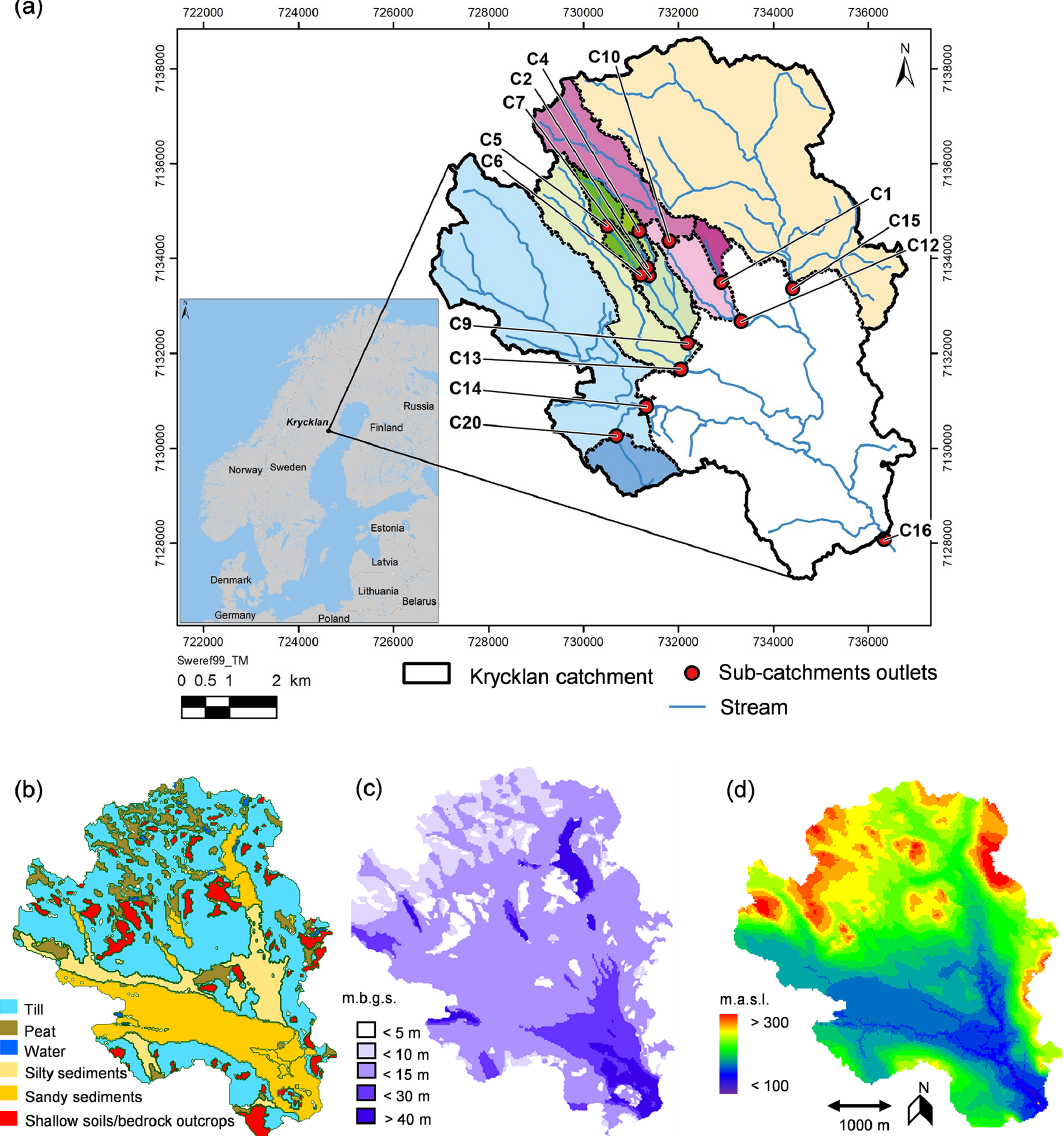
Figure 1. The Krycklan catchment. (a) Locations of sub-catchments and their outlets. The areas are colour-coded based on their stream network connections; e.g. all sub-catchments of one colour connect before reaching the white area. For further details of the catchment characteristics, see Table 1. (b) The figure shows the soil map used in the Mike SHE flow model, which is based on data from the Swedish Geological Survey soil map (1 : 100000) and field investigations. (c) Soil depth to bedrock map taken from the Swedish Geological Sur- vey (2016) and is shown in metres below the ground surface (mb.g.s.). (d) Catchment topography, shown as metres above sea level